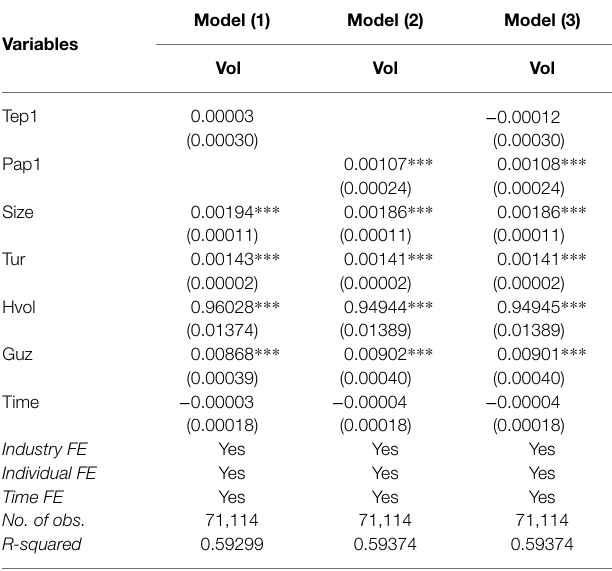
TABLE 7 | Robustness checks for the alternative measure.